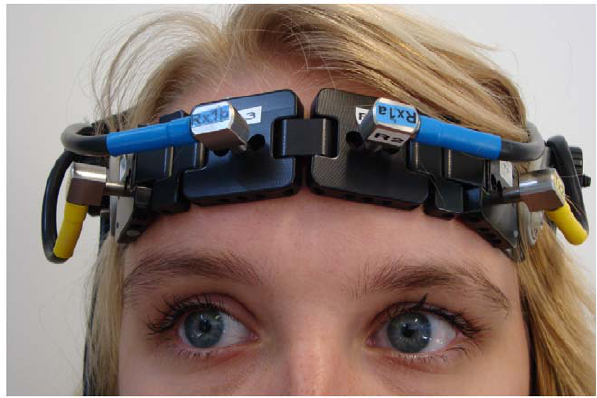
Figure 2. Positioning of the two pairs of fNIRS optodes. The subject of the photograph has given written informed consent (as outlined in the PLoS consent form) to publication of her image.